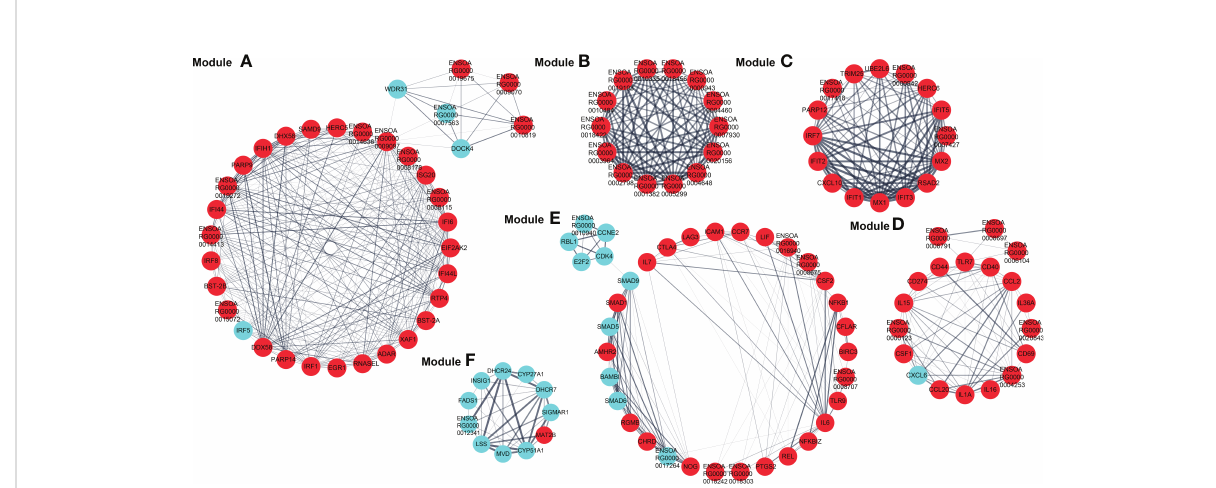
FIGURE 8 Modules (A – F) extracted from PPI network. The MCODE plugin in Cytoscape was applied to extract densely connected modules from PPI network, with degree cut-off = 2, node score cut-off = 0.2, K-score = 2, and max depth = 100. Red and blue circles represented upregulated and downregulated dif-mRNAs, respectively, whereas the thickness of the solid black line indicated the strength of the corresponding protein